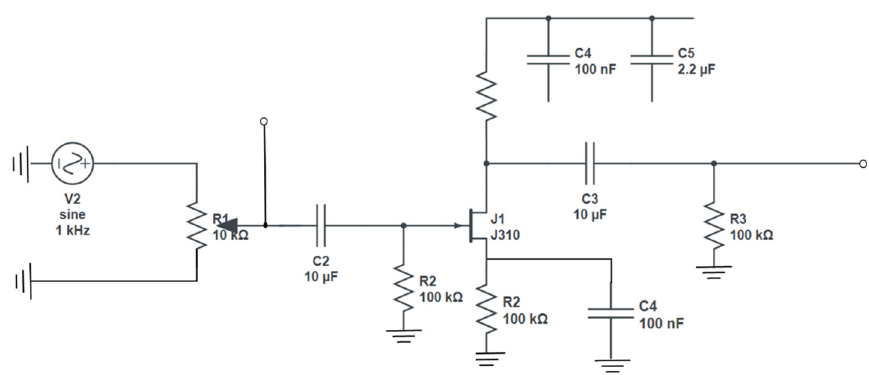
Figure 2. Circuit diagram for the JFET amplifier used in this work.